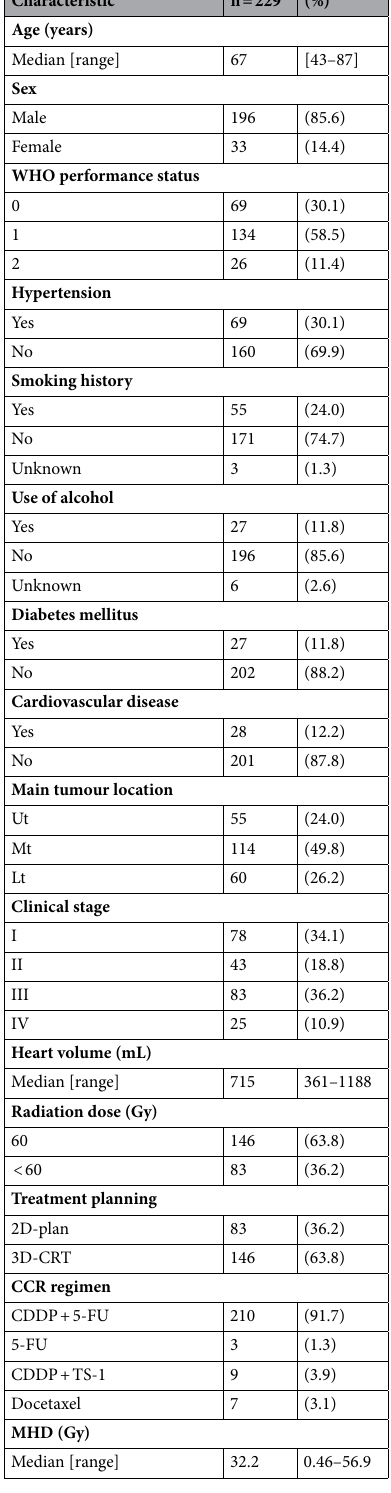
Table 1. Demographic and clinical characteristics of patients included in the study cohort. 2D-plan: two- dimensional treatment plan; 3D-CRT: three-dimensional conformal radiotherapy; 5-FU: 5-fluorouracil; CCR: concurrent chemoradiotherapy; CDDP: cisplatin; Lt: lower thoracic oesophagus; MHD: mean heart dose; Mt: middle thoracic oesophagus; TS-1: Tegafur/Gimeracil/Oteracil; Ut: upper thoracic oesophagus; WHO: World Health